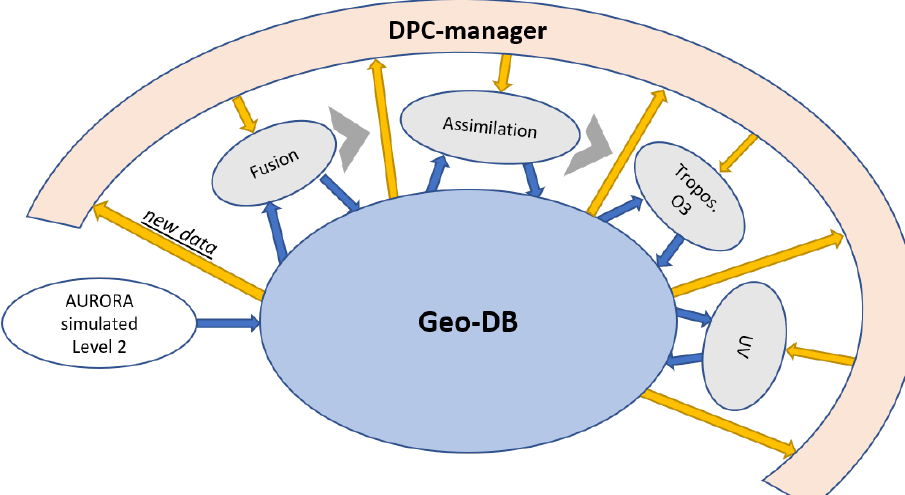
Figure 4. Logic flow of the distributed data processing. Yellow arrows indicate notification messages from geo-DB to DPC- manager and from DPC-manager to the processing modules; blue arrows indicate the data flow (input data downloaded from geo-DB and output data uploaded to geo-DB after